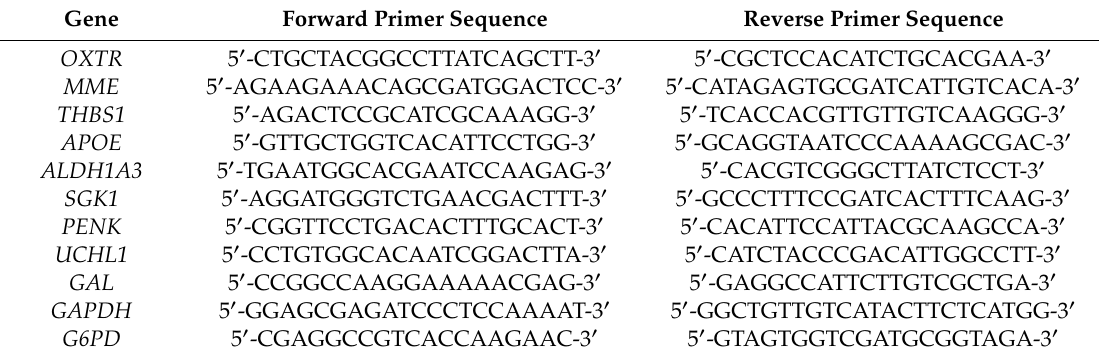
Table 6. Primers used in